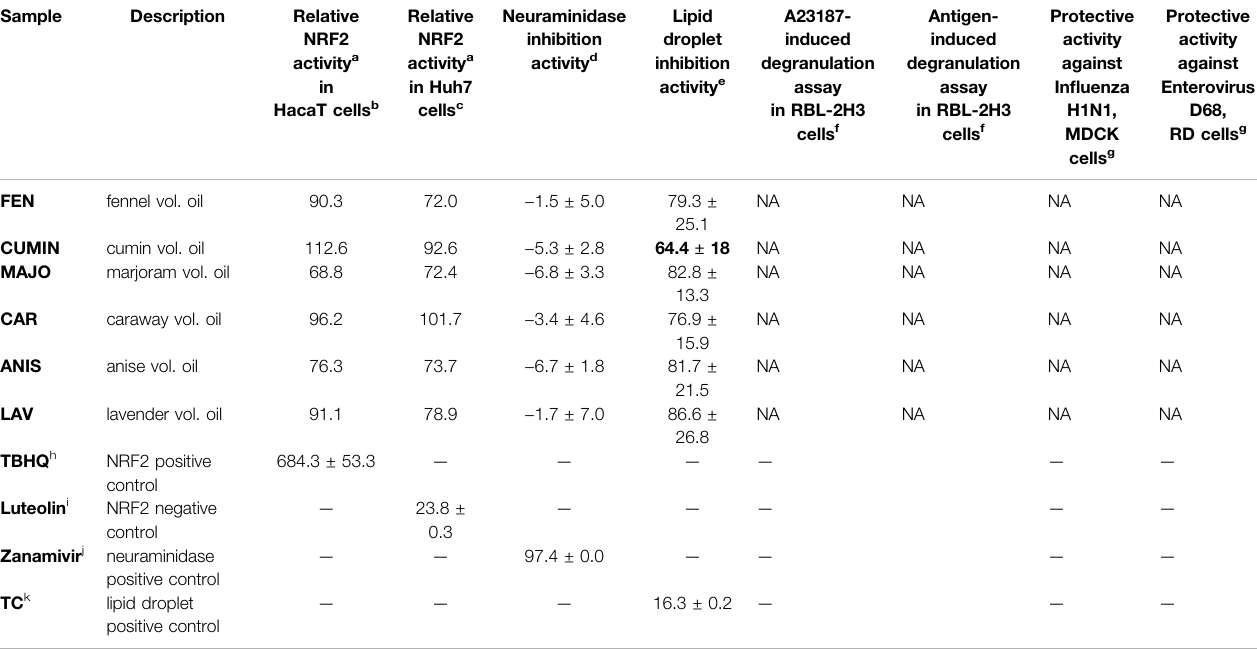
TABLE 1 | Bioactivity screening of volatile oils common in the Mediterranean diet.